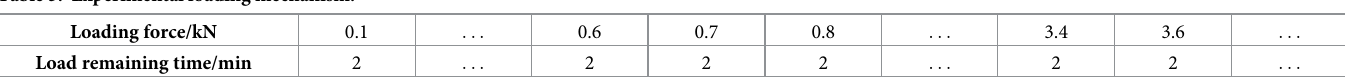
Table 3. Experimental loading mechanism.